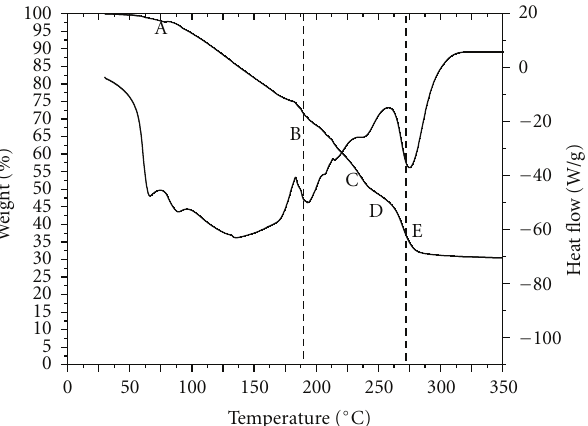
Figure 3: Cobalt nitrate decomposition DSC analysis.